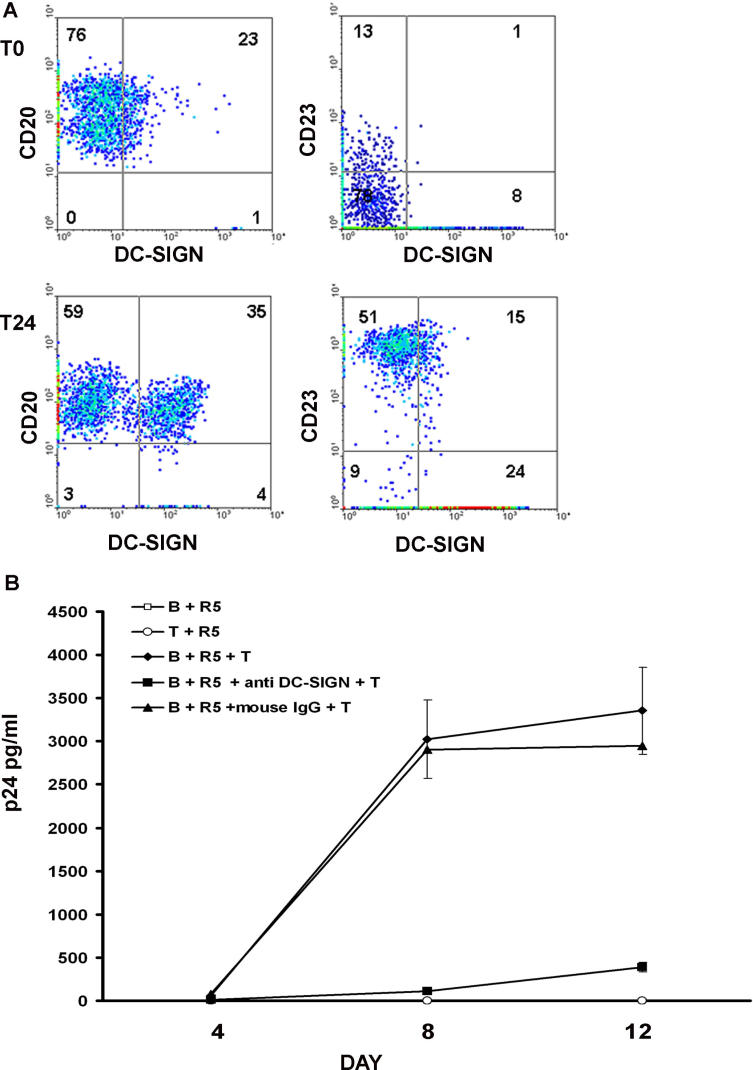
DC-SIGN–Expressing Tonsil B Cells Mediate trans Infection of T Cells(A) Expression of CD20 and DC-SIGN or CD23 and DC-SIGN in fresh (time 0 h; T0) and IL-4– and CD40L-activated (time 24 h; T24) B cells derived from tonsils. Data are from one experiment representative of five independent experiments.(B) Levels of HIV-1 p24 in co-cultures of B and T cells derived from tonsils. B cells were stimulated with IL-4 and CD40L for 24 h, treated with anti–DC-SIGN mAb or mouse Ig (20 μg/ml) or left untreated, and loaded with 10−4 MOI of HIV-1 R5 (Ba-L) for 2 h at 37 °C, then extensively washed in cold medium and incubated with purified, autologous CD4+ T cells (T). B cells and T cells directly loaded with HIV-1 served as controls. Amount of HIV-1 p24 in the cell culture supernatants was determined by ELISA. Data are from one experiment representative of two independent experiments.